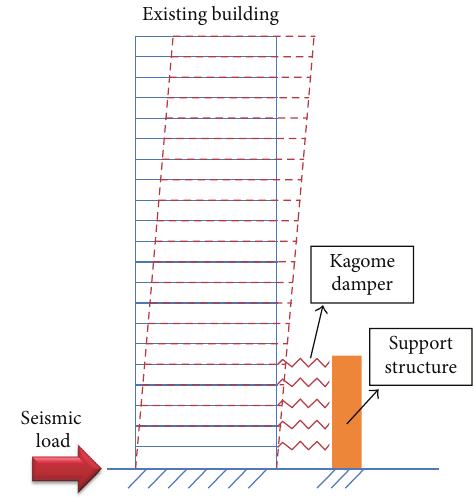
Figure 2: Concept of the external connection methodology using a wire-woven bulk Kagome truss.